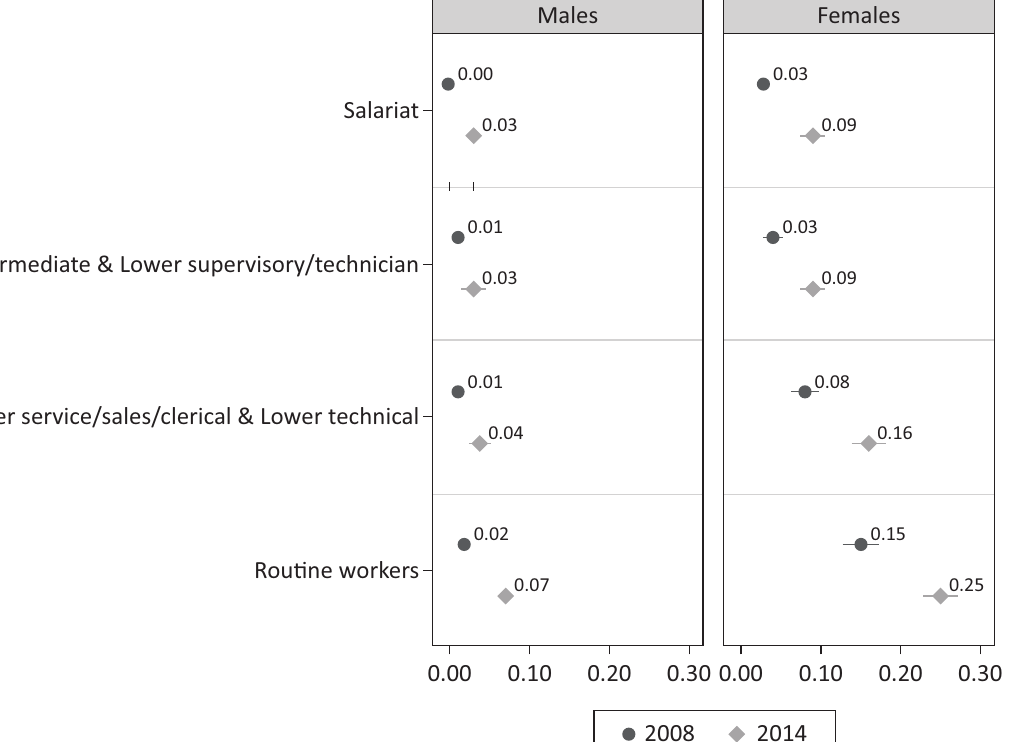
Figure A1. Predicted probabilities of involuntary part-time work across social classes in 2008 and 2014. Notes: Controls for ethnicity, first generation, age, education, civil status, dependent children and degree of urbanisation. Notes: N = 77,284 (only working sample); age 16–64, not in education/training or retired; self-employed/small employers excluded due to low number of cases (160); bars represent 90% confidence intervals; weighted and clustered by